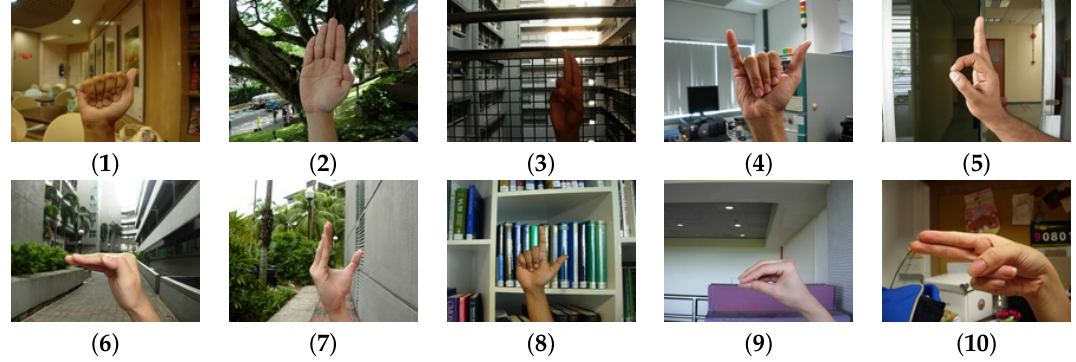
Figure 2. Samples of each hand posture (including its number labelling) that are contained in the National University of Singapore (NUS) Hand Posture Dataset II. The samples show the complexity of the backgrounds, the different lighting conditions and several hand